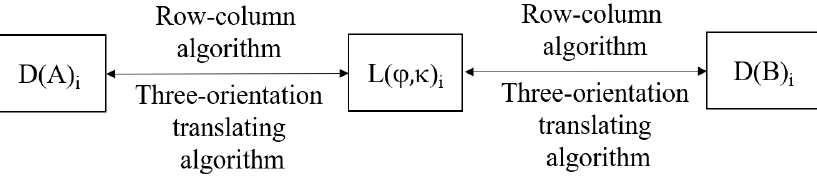
Figure 13. Algorithm flow chart of QTM encoding through the row–column conversion method.